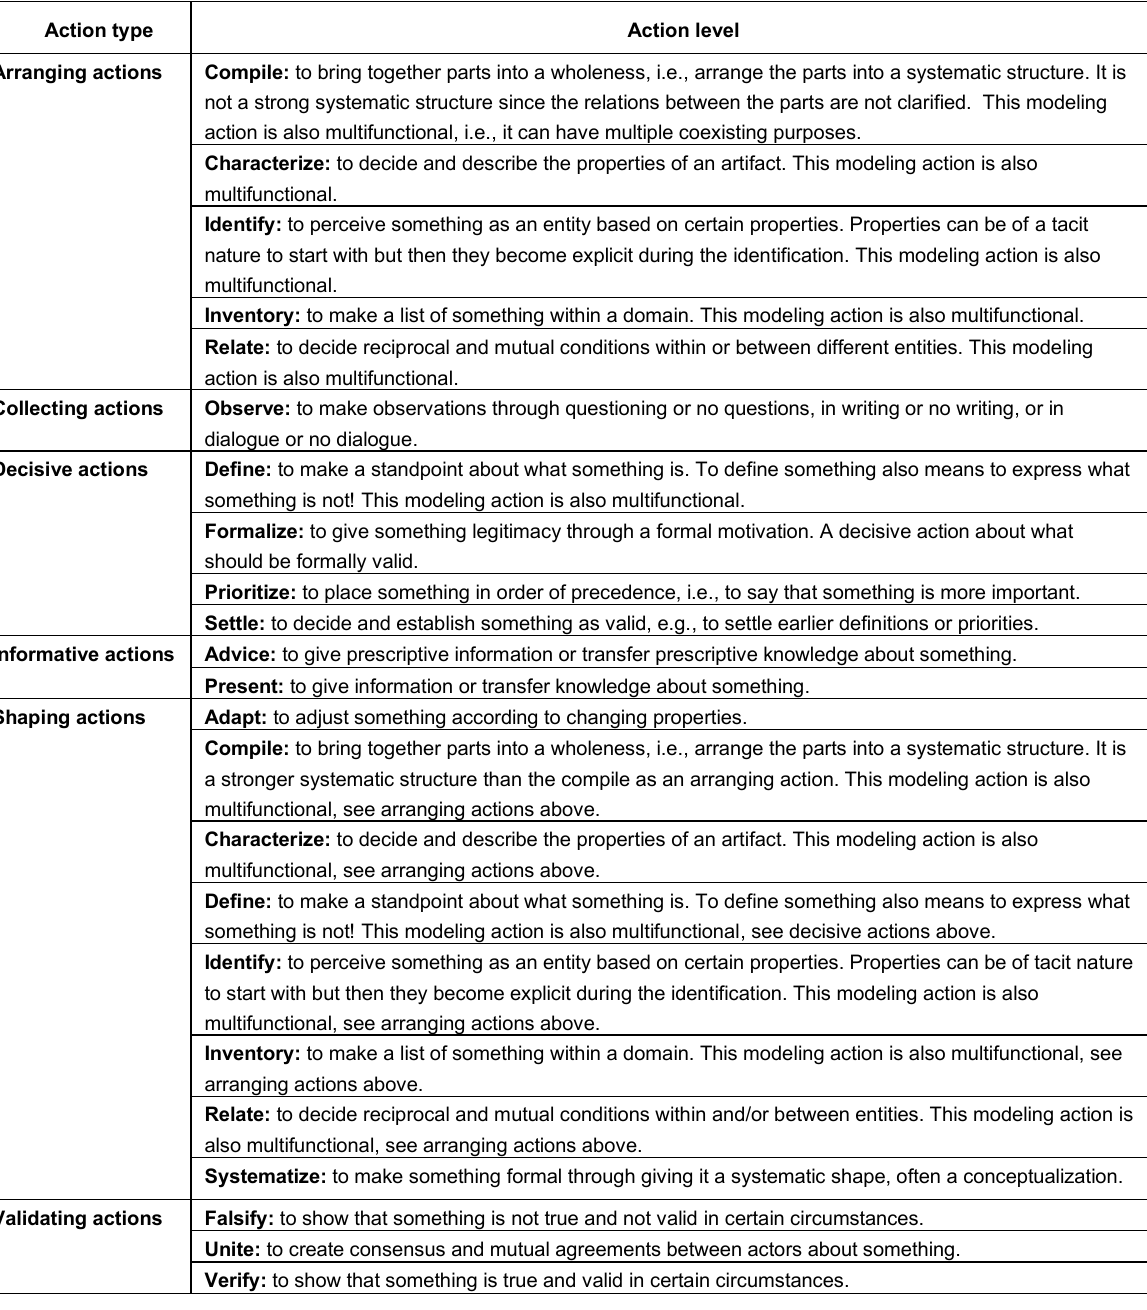
Table 1. Actions types with corresponding actions for